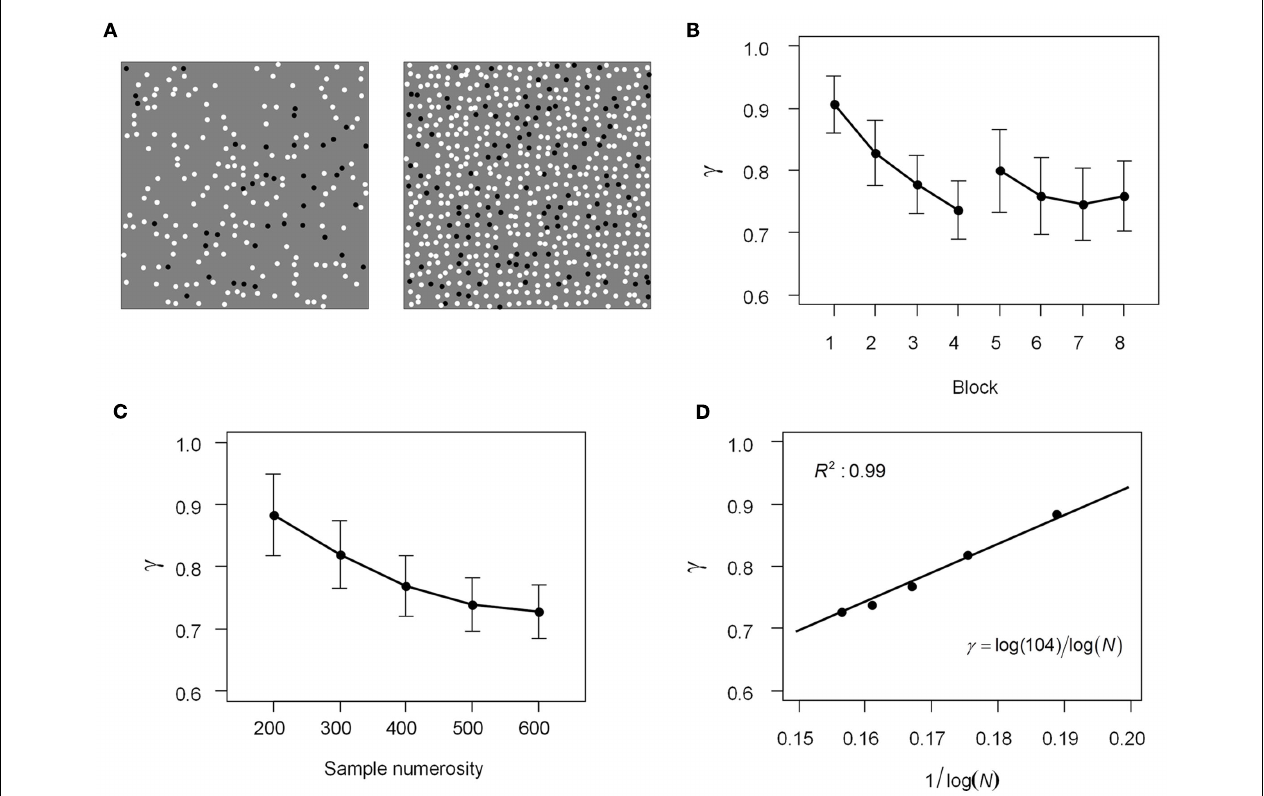
experience led to greater distortion ( γ further from 1). Error bars denote SEs of the mean. (C) Effect of sample numerosity.The slope γ across 11 participants is plotted as a function of sample numerosity N (the total number of dots displayed in a trial). Larger sample numerosity resulted in greater distortion ( γ further from 1). Error bars denote SEs of the mean. (D) The function of the mean γ to sample numerosity, N . Dots denote data. Solid line denotes the fit of γ as proportional to the reciprocal of log N